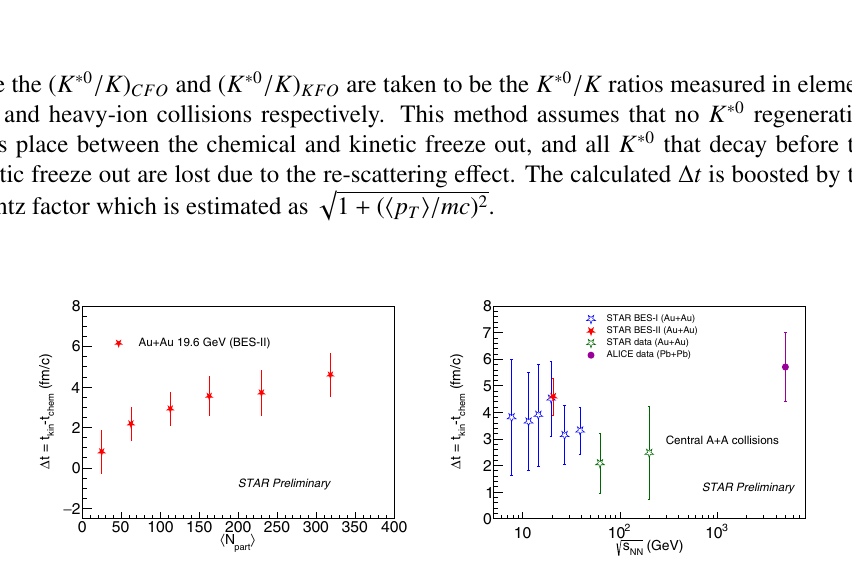
Figure 2. Left panel: Resonance to non-resonance ratio as a function of model predication . Here K ∗ 0 / K and ϕ/ K (BES-I)[2] denotes ( K ∗ 0 + K ∗ 0 ) / ( K + + K − ) and 2 ϕ / ( K + + K − ) respectively. Here the K ∗ 0 measurement is based on BES-II data, whereas the measurement of kaons is from BES-I [3]. Hence their systematic uncertainties are denoted by di ff erent boxes. Right panel: Figure 1. K ∗ 0 signal for 1.0 < p T < 1.2 GeV / c in 0-10% Au + Au collisions at √ s NN = 19.6 GeV. K ∗ 0 / K as a function of collision energy [4–23]. The bars and caps (boxes) denote the statistical and systematic uncertainties respectively. which is then fitted with the Breit-Wigner function and a first-order polynomial representing